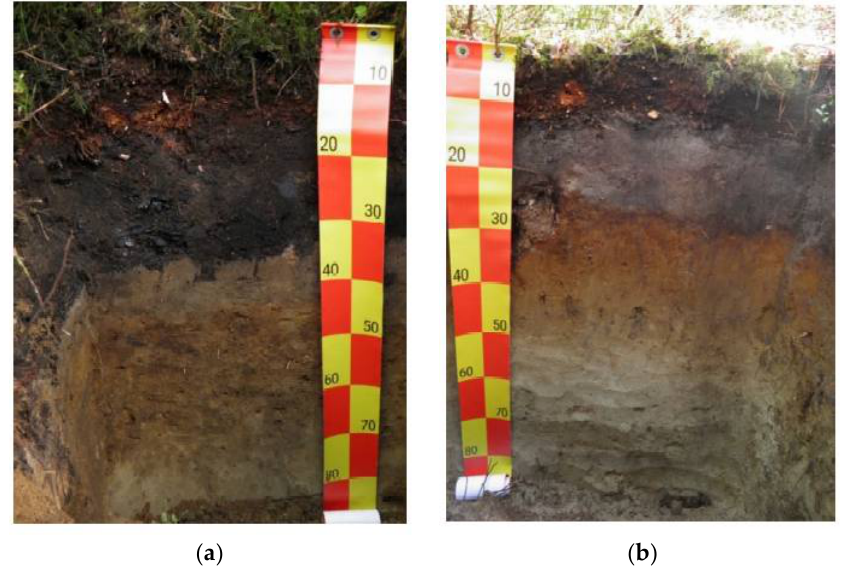
Figure 2. Soil profile with charcoal ( a ) and soil profile without charcoal ( b ). Table 1. C and N content and acidity of the examined soil